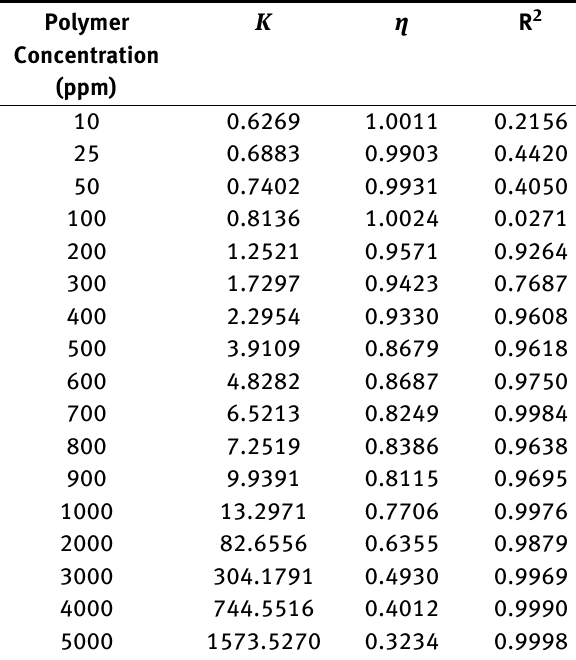
Table 11: Fit parameters to the Power Law Model for 77 ∘ C/220,000 ppm NaCl